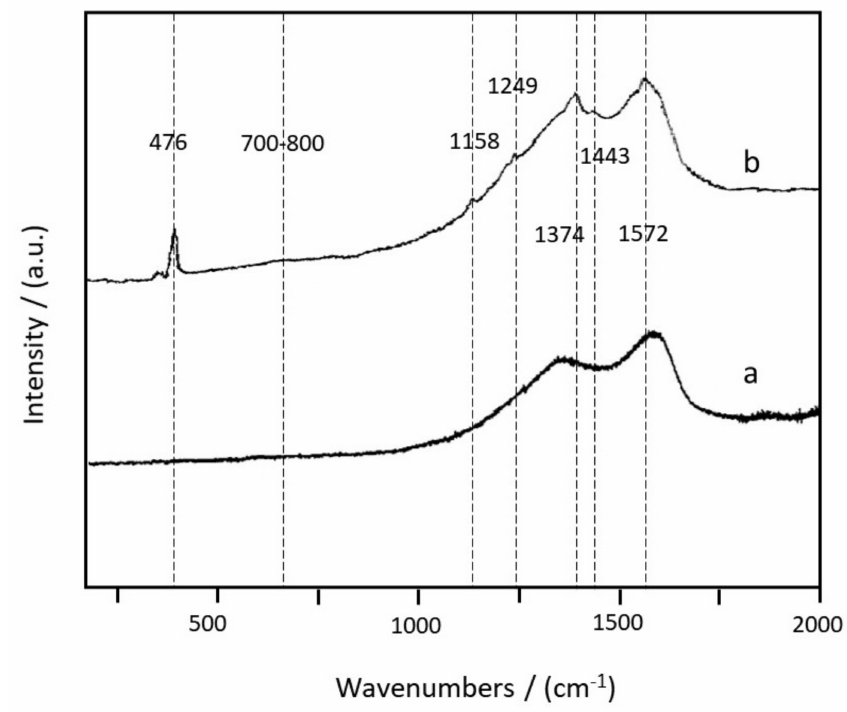
Figure 3. ( a ) Raman spectra of pure PANI; ( b ) Raman spectra of poly (AN–Ag–S)